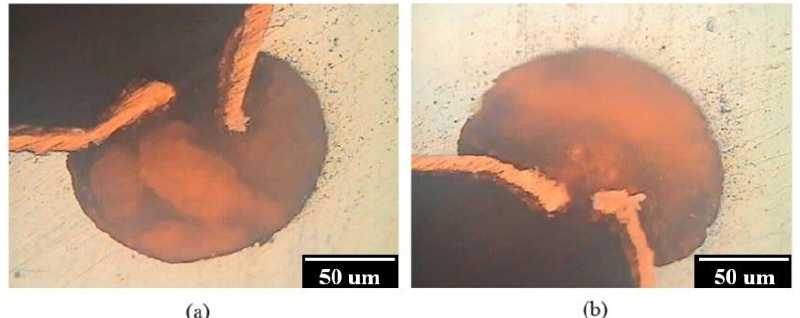
Figure 11. Cross sections of the inner ( a ) lower and ( b ) upper sites of U-shape surface of AZ 80 specimen prepared at a rotation speed of 500 rpm after Cu electrodeposition in the acidic Cu-plating